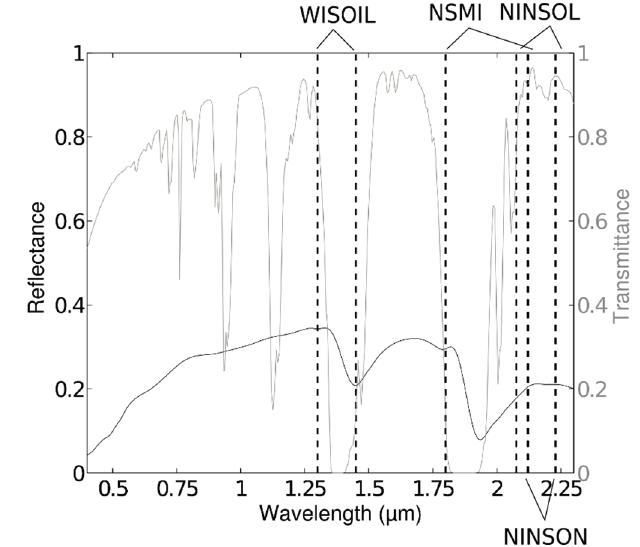
Figure 6. Example of a bare soil sample reflectance spectrum, superimposed with the index bands located by vertical dotted lines and with the atmospheric transmittance (in